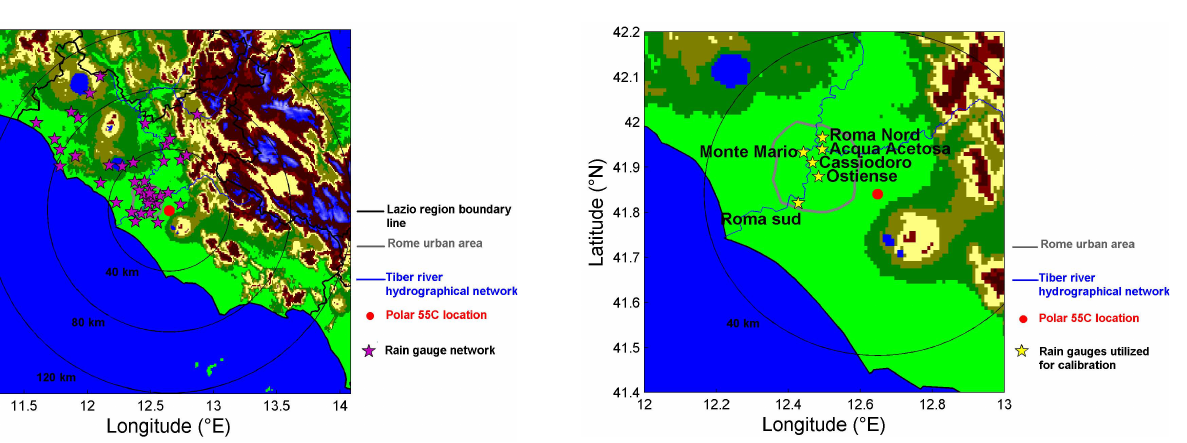
Fig. 2. Locations of rain gauges utilized to perform Polar 55C cali- bration.